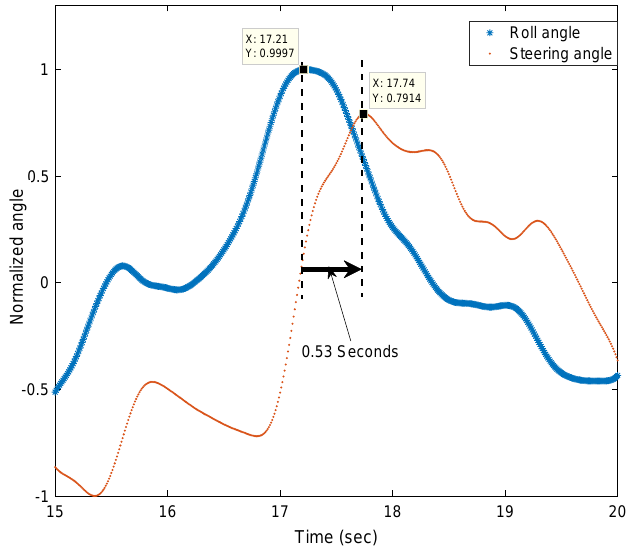
Figure 6. Steering angle and roll angle curve of a rider normalized in [ − 1,1] range @ 3.1